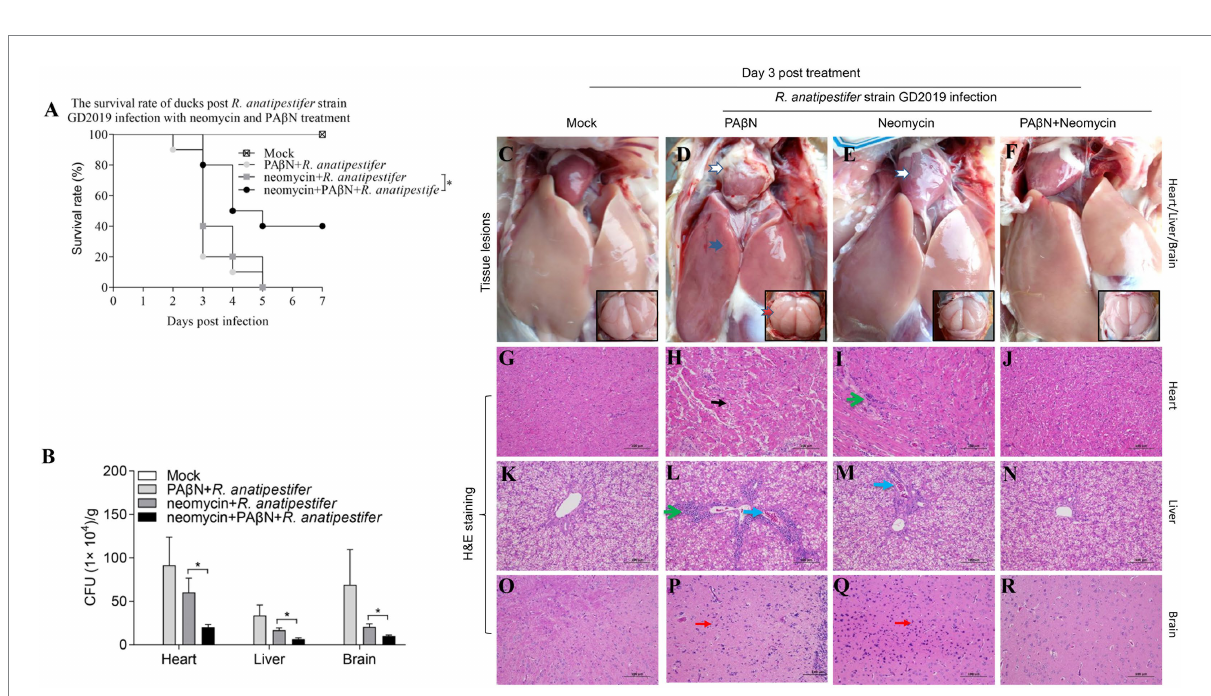
FIGURE 4 Enhancing effect of PA β N for neomycin against GD2019 infection in ducks. (A) The survival rate of ducks ( n = 10). (B) Bacterial loads in heart, liver, and brain (mean ± SD, n = 5. *stands for p < 0.05). (C–F) Macroscopic pictures of heart, liver, and brain. (G–R) H&E-stained heart, liver, and brain tissue section. → Pericarditis, → Perihepatitis, → Meningitis, → Myocardial necrosis, → Inflammatory cell infiltration, → Congestion, → Microgliosis.